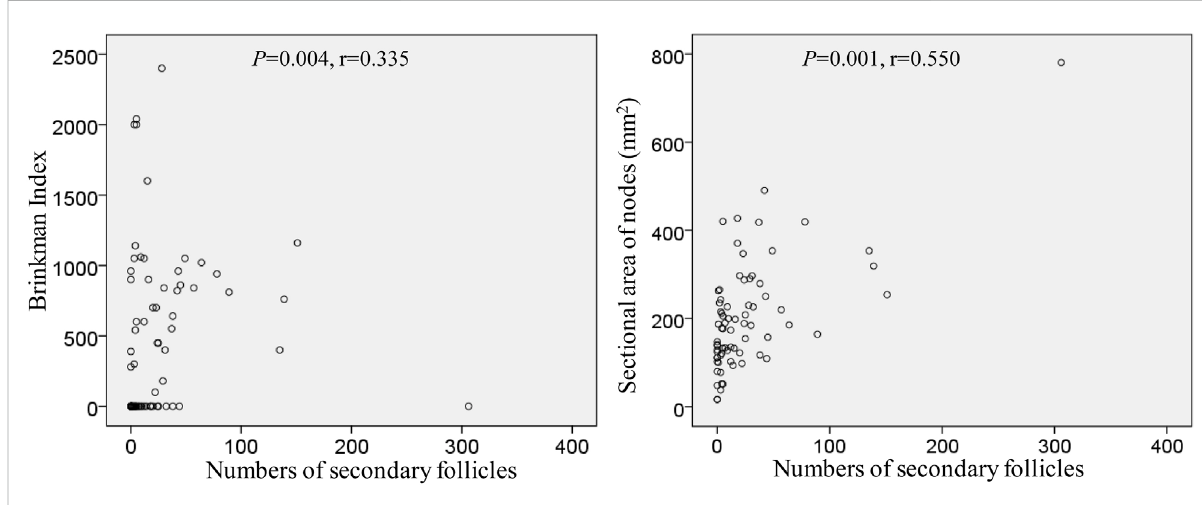
FIGURE 10 Positive correlation of numbers of secondary follicles with smoking index as well as a sectional area of the